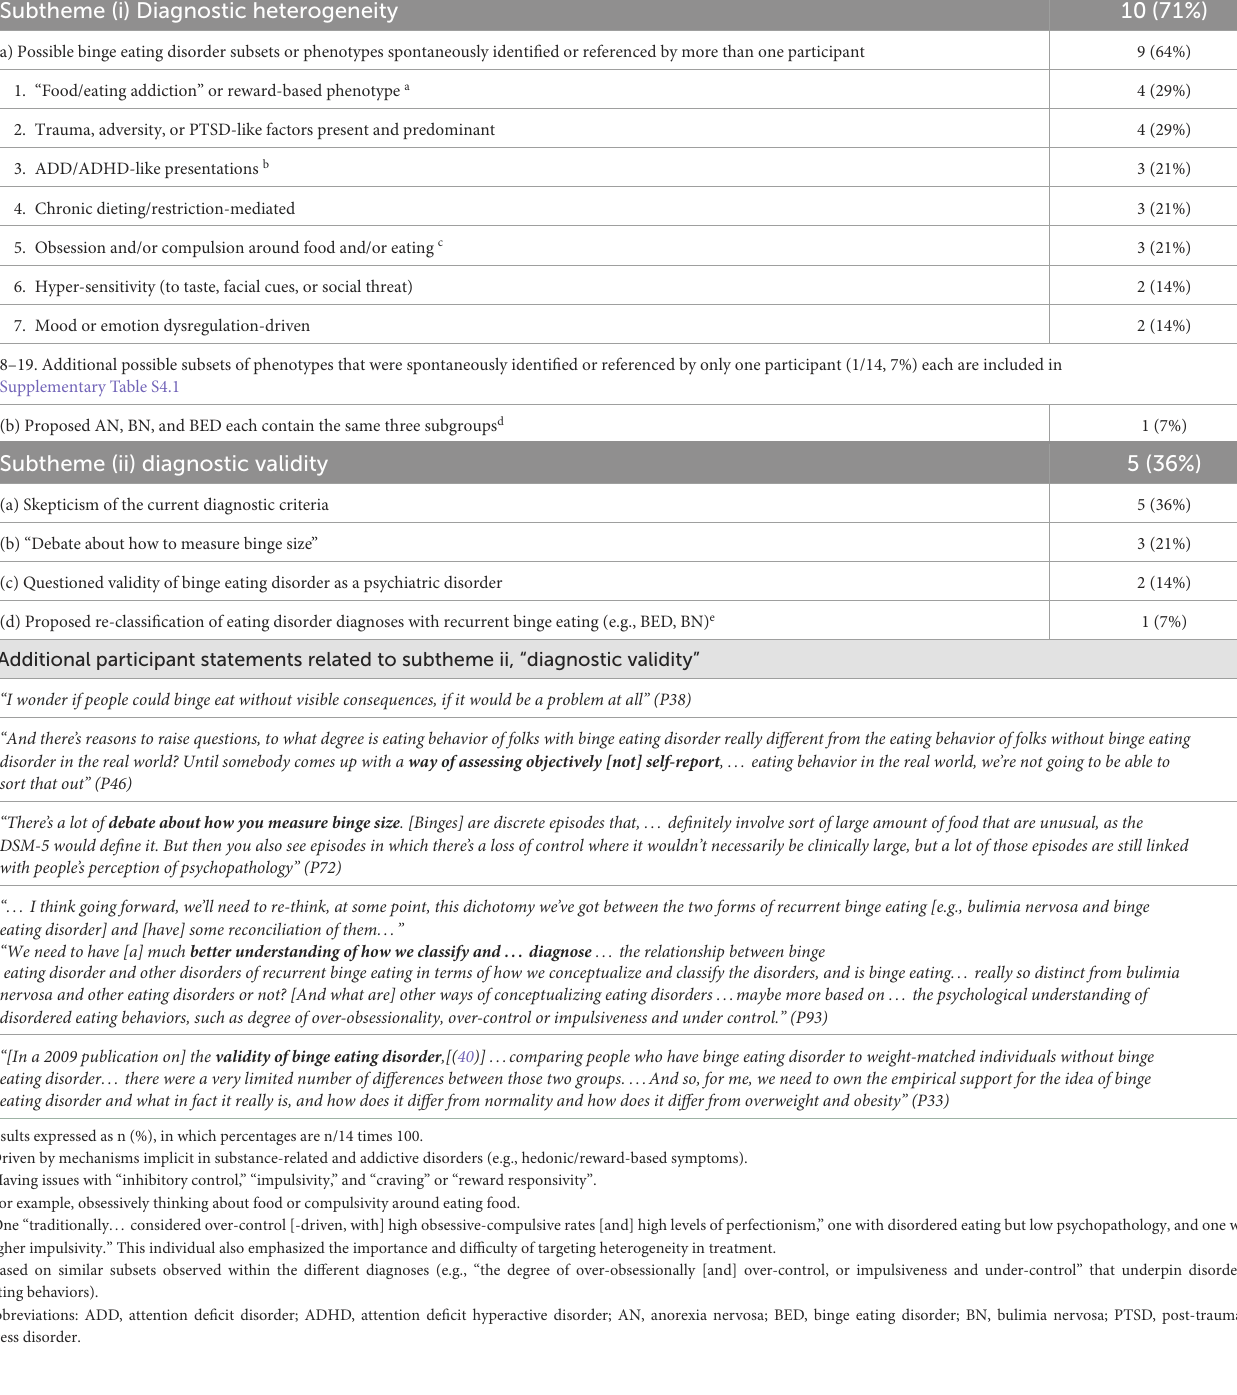
TABLE 11 Participant statements related to theme 4, “diagnostic heterogeneity and